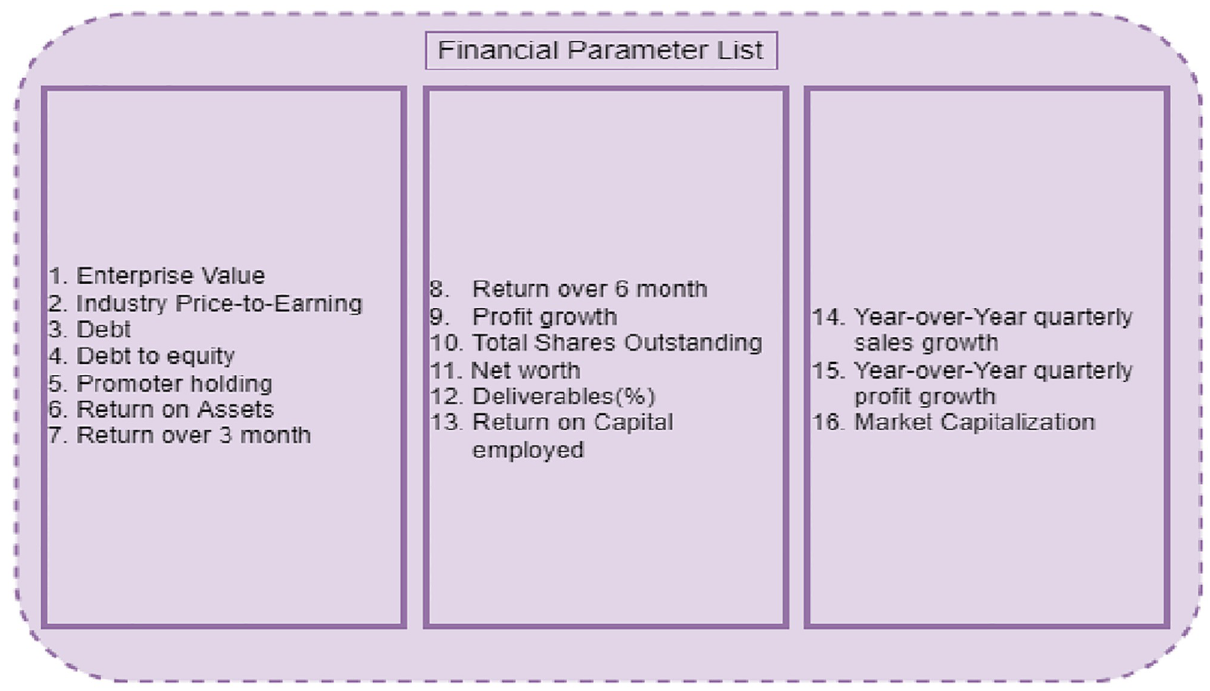
Fig 6. HFS based final selected